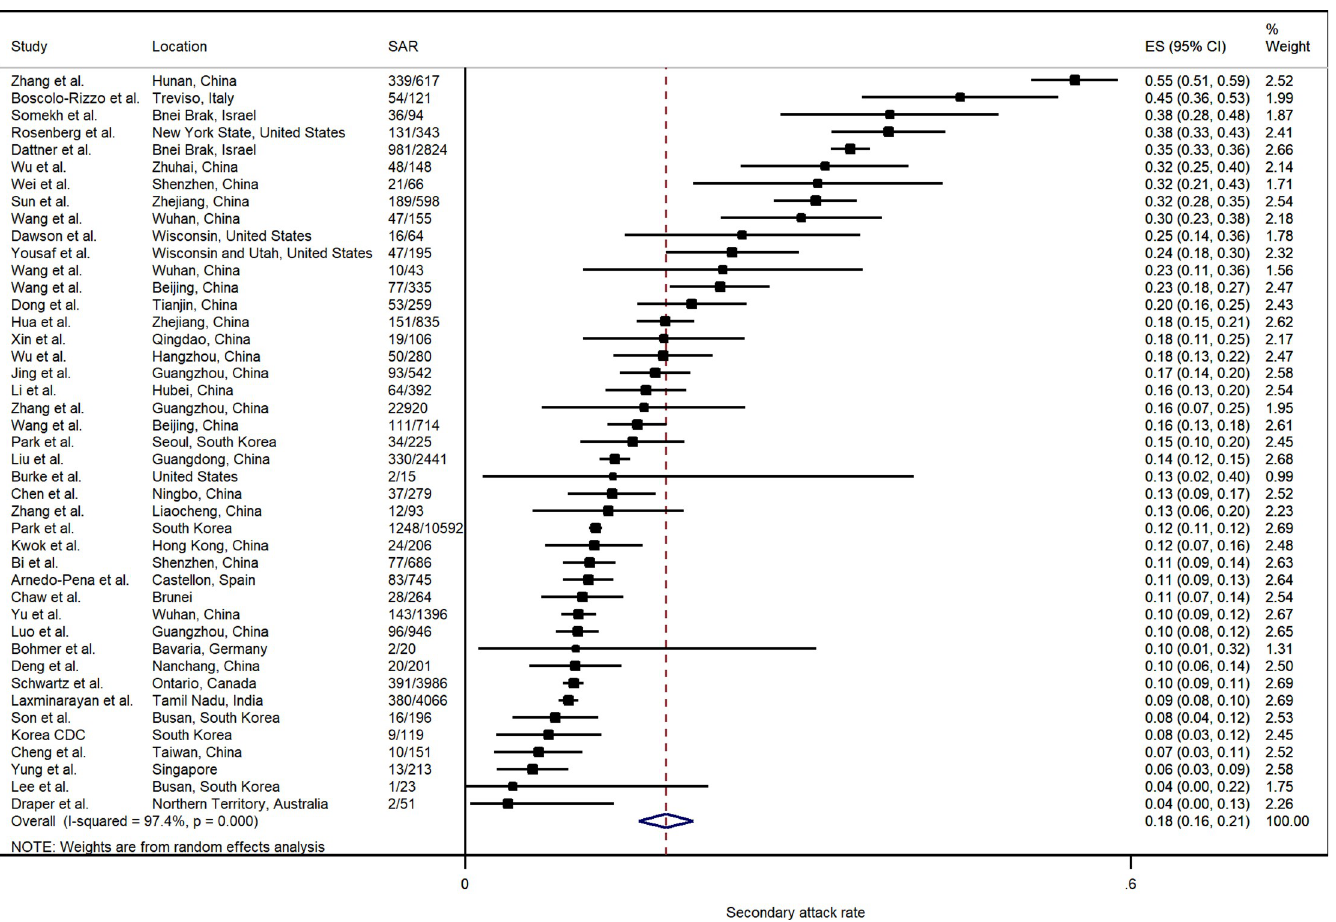
Fig 2. Forest plot of household secondary attack rates (SAR). ES is the estimated SAR, with 95% confidence intervals (CI). I-squared is the percentage of between- study heterogeneity that is attributable to variability in the true effect, rather than sampling variation.